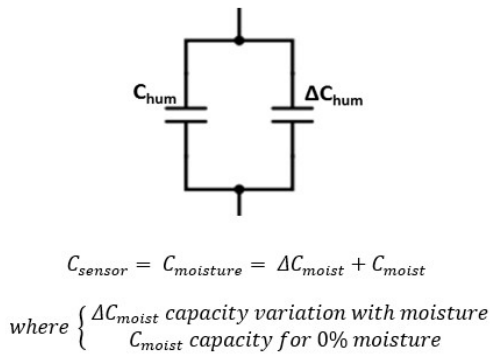
Figure 22. Sensor final electrical model as a function of moisture.